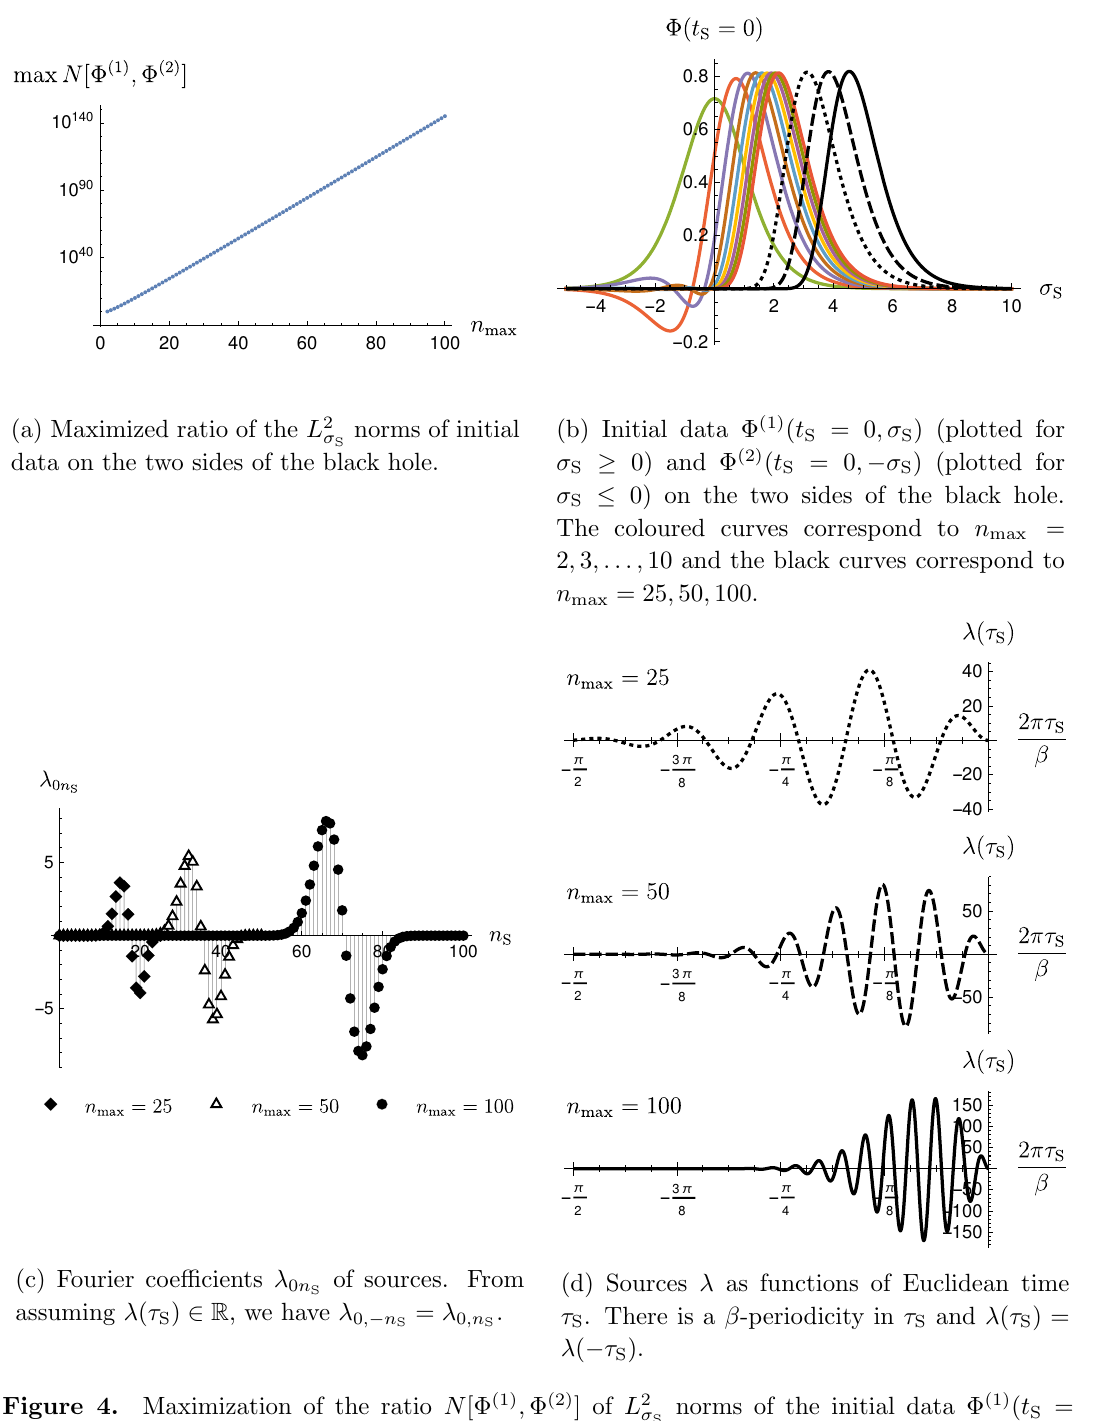
(c) Fourier coefficients λ 0 of sources. From (d) Sources λ as functions of Euclidean time n S = λ 0 . assuming λ ( τ S ) τ S . There is a β -periodicity in τ S and λ ( τ S ) = R , we have λ 0 , n S ,n S ∈ − λ ( τ S ). − norms of the initial data Φ (1) ( t S = Figure 4. Maximization of the ratio N [Φ (1) , Φ (2) ] of L 2 σ S 0) , Φ (2) ( t S = 0) on the two sides of the black hole. The sources are assumed to be real functions of Euclidean